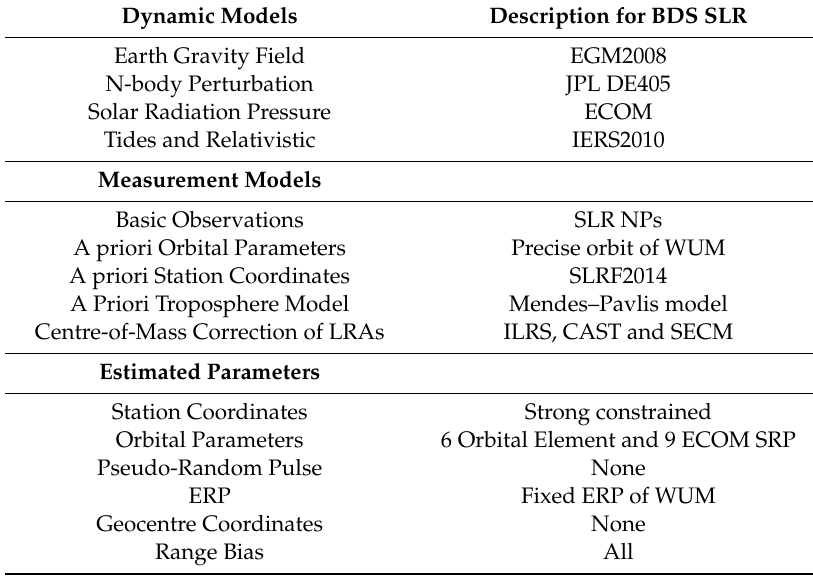
Table 1. The configuration of parameters of Satellite Laser Ranging (SLR)-only orbit determination.